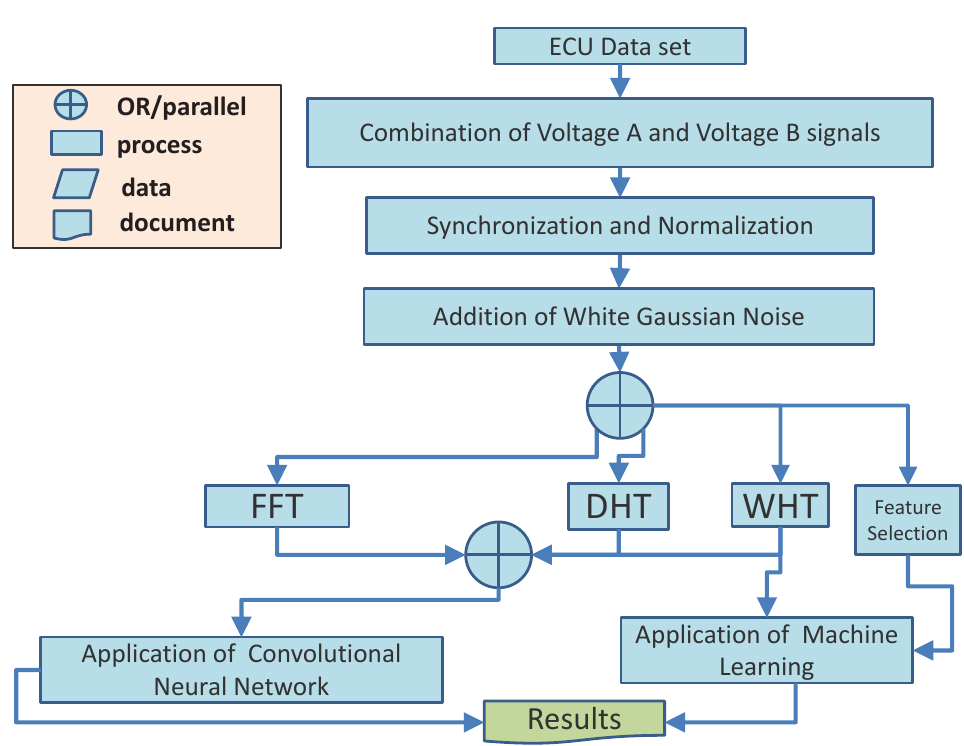
Figure 1. Overall workflow of the proposed